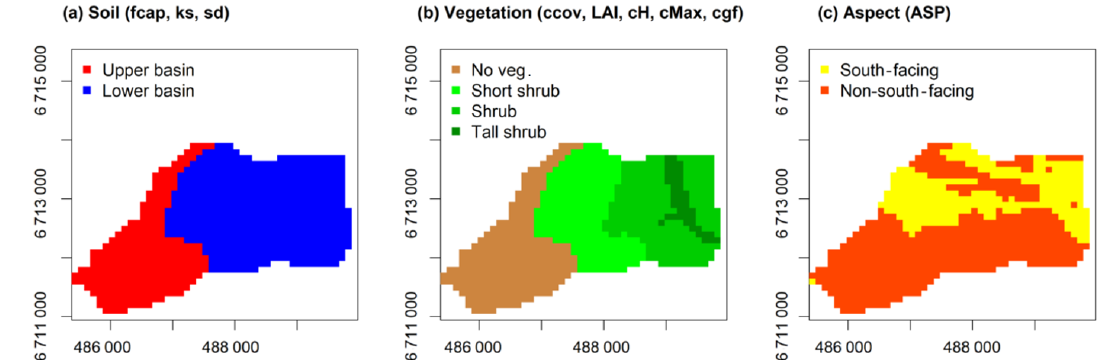
Figure 3. Aggregation used to set the spatially variable parameters: (a) soil classification for two calibrated parameters (fcap is volumetric field capacity and ks is recession coefficient) and one fixed parameter (sd is soil depth), (b) vegetation classification for five fixed parameters (ccov is canopy coverage, LAI is leaf area index, cH is canopy height, cMax is maximum canopy storage and cgf is canopy gap fraction), and (c) aspect classification for ASP parameter that was calibrated if south-facing or set to 1 for any non-south-facing